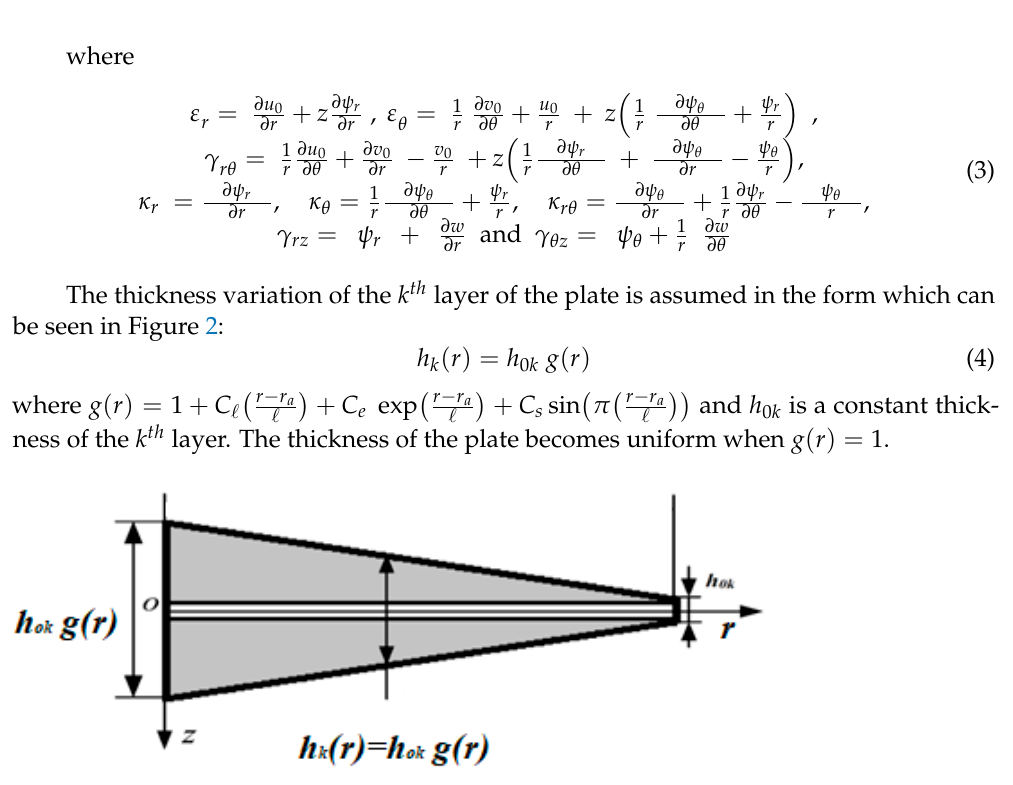
Figure 2. Plate of variable thickness.